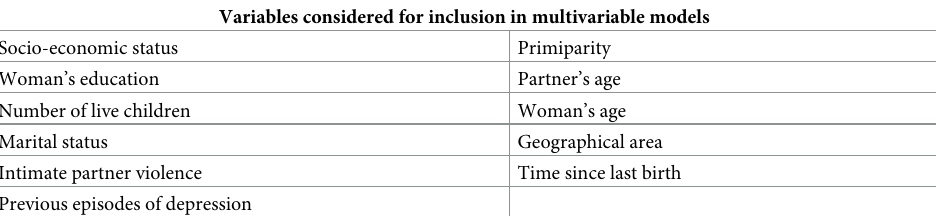
Table 1. Determinants of pregnancy intention considered for inclusion in the multivariable